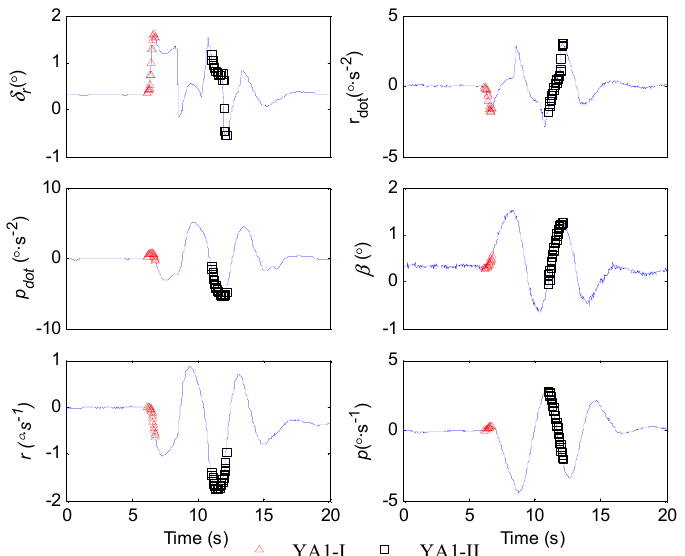
Figure 9. Data segments of response of rudder 3-2-1-1 input for yaw moment derivative identification.